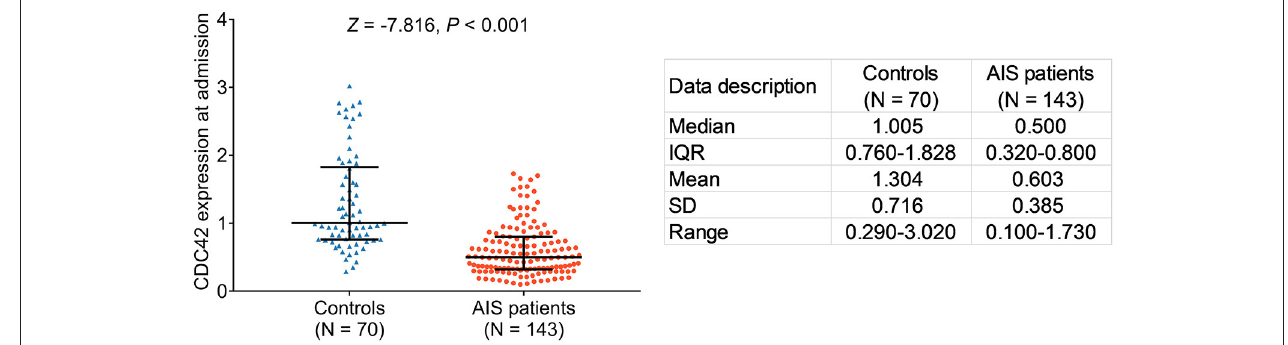
FIGURE 2 | Cell division cycle 42 (CDC42) was decreased in patients with acute ischemic stroke (AIS) than in controls.